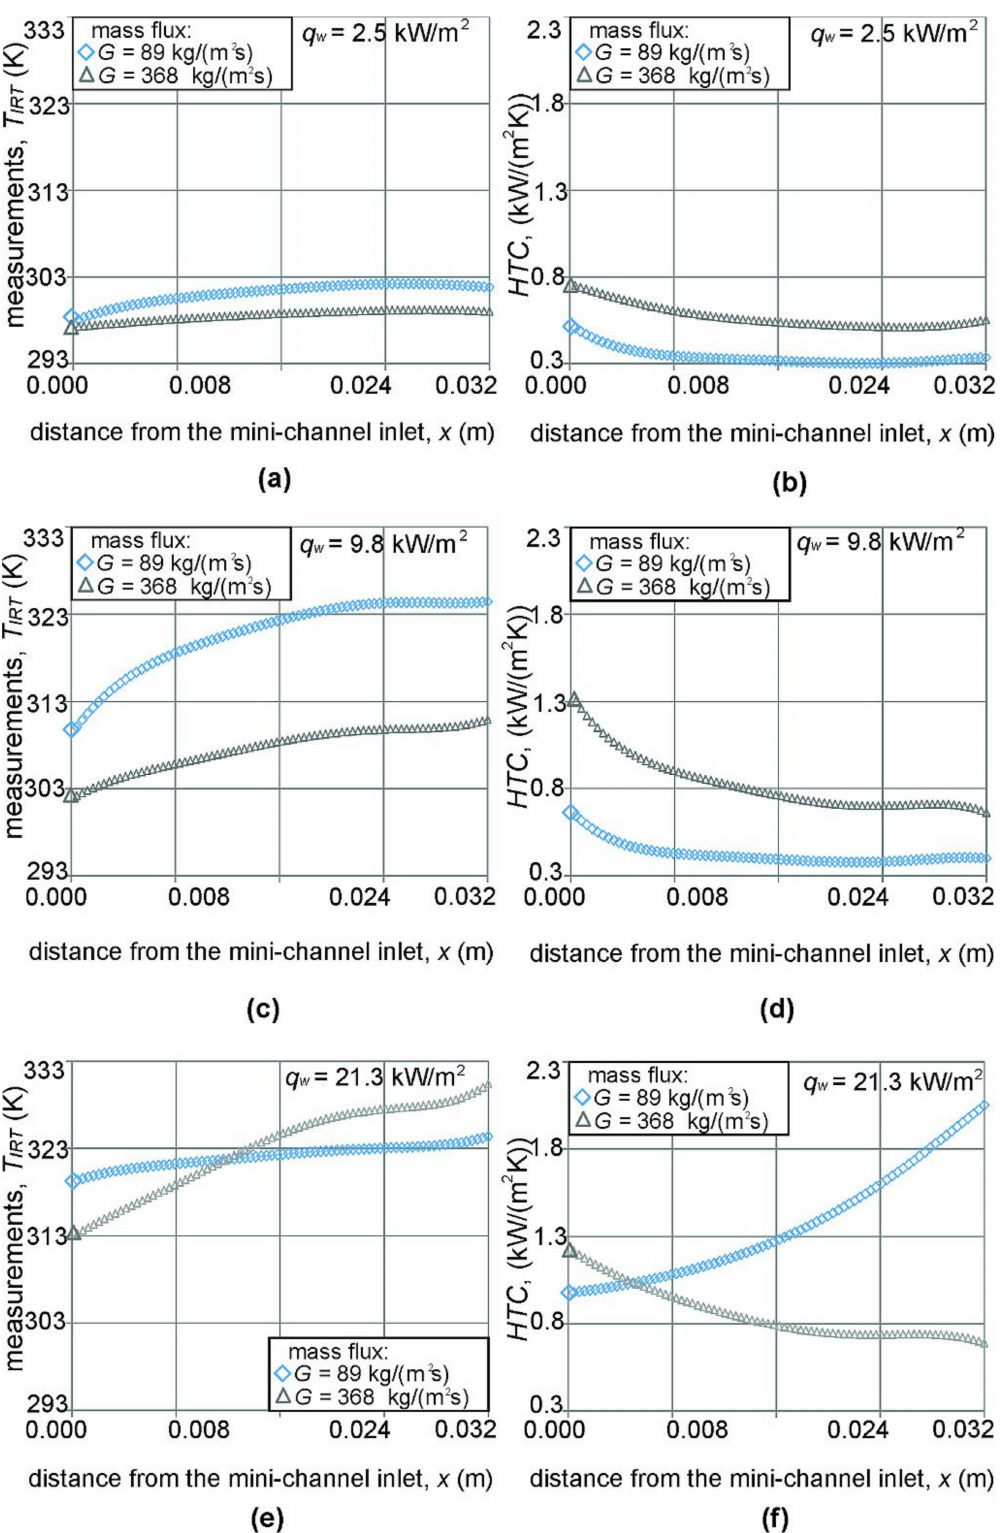
Figure 8. Plate temperature measurements using the IR camera ( a , c , e ) and heat transfer coefficient ( b , d , f ), both vs. distance from the mini-channel inlet; subcooled boiling region; various mass fluxes; vertical channel orientation (90 ◦ ); smooth heated plate; FC-72; L IRT = 32